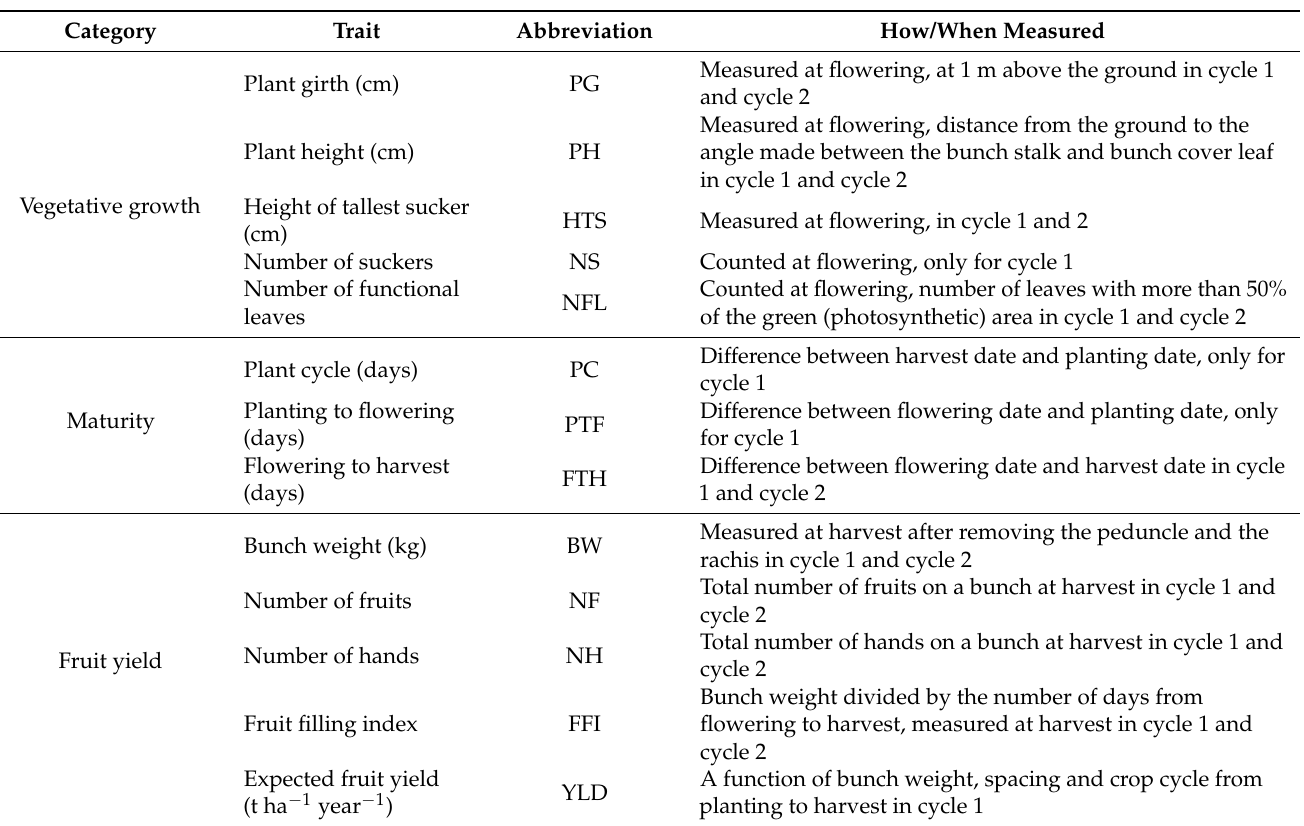
Table 2. List of agronomic traits considered at flowering and harvest for the four Musa genotypes evaluated in this study over two consecutive crop cycles.